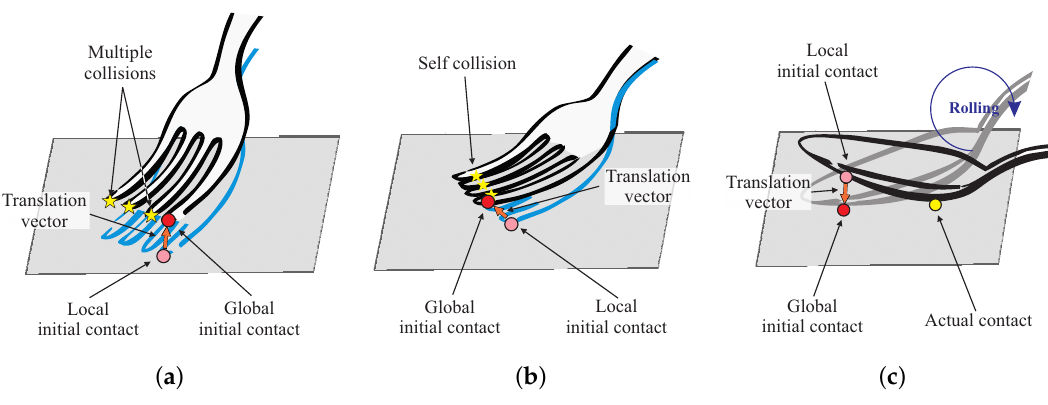
Figure 2. Complex contact deformation: our data-driven model provides a non-linear input-output mapping that allows simulating the following deformations ( a ) multiple-contact; ( b ) self-collision; and ( c ) rolling-contact.